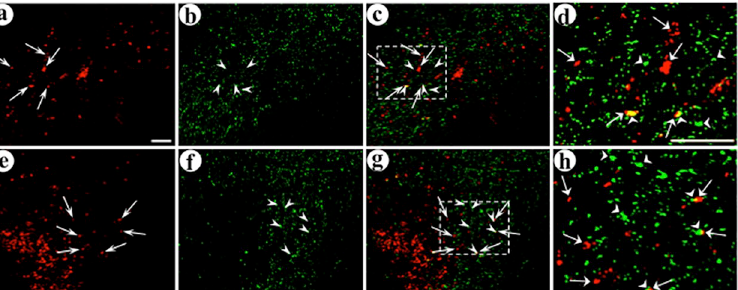
Fig 7. The synthetic peptide neurotransmitter dcv-pomc/anti-GABA A ß2or3-LtoH/his-tag supports limited gene transfer to connected neurons. The experimental design and immunofluorescent costaining were as above. (A-D) Delivery of this presynaptic vector followed by the targeted postsynaptic vector resulted in only low levels of gene transfer to connected neurons; (A) His tag-IR, (B) GFP-IR, (C) merge, and (D) merge, with an enlarged area that contains a number of transduced axons and dendrites; some transduced axons are proximal to a transduced dendrite and other transduced axons are distant from a transduced dendrite. Arrows, transduced axons; arrowheads, transduced dendrites. (E-H) Delivery of this presynaptic vector, followed by the untargeted postsynaptic vector, supported low levels of gene transfer to connected neurons, similar to those observed using the targeted postsynaptic vector; (E) His tag-IR, (F) flag-IR, (G) merge, and (H) merge, an enlarged area that shows transduced axons that are either proximal to, or distant from, transduced dendrites. Scale bars: (A-C and E-G) 50 μ m, and (D and H) 50 μ